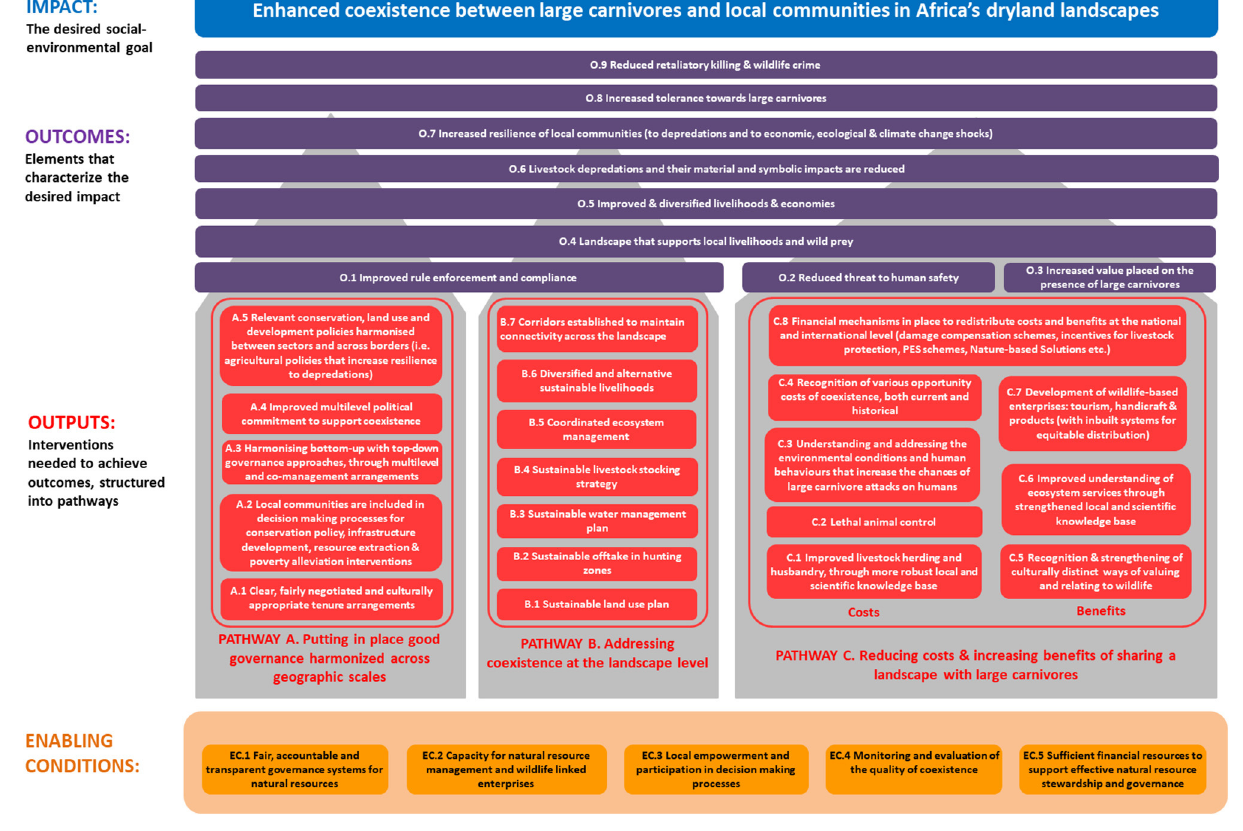
FIGURE 1 | The Theory of Change for enhanced coexistence between large carnivores and local communities in Africa’s dryland